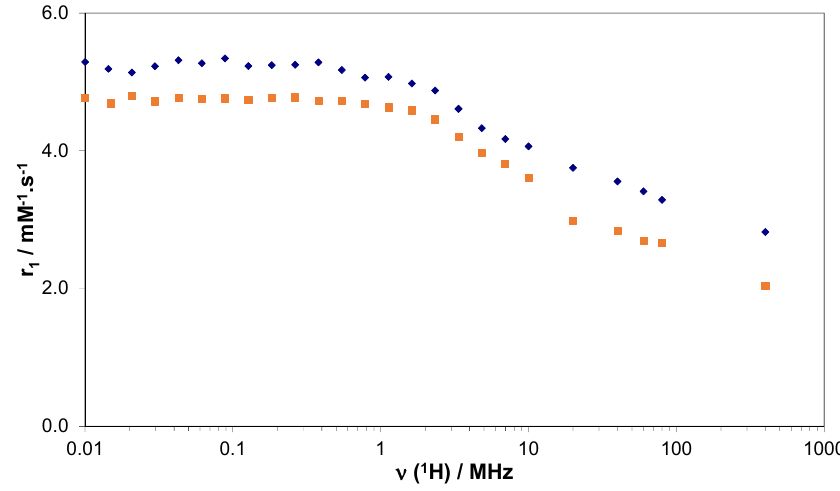
Figure 2. 1 H NMRD profiles of 4 ( ) and 5 ( ) at 25 °C and pH = 7.0.